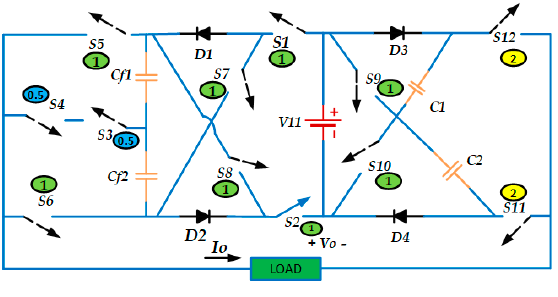
Figure 15. 13 − Level MLI.